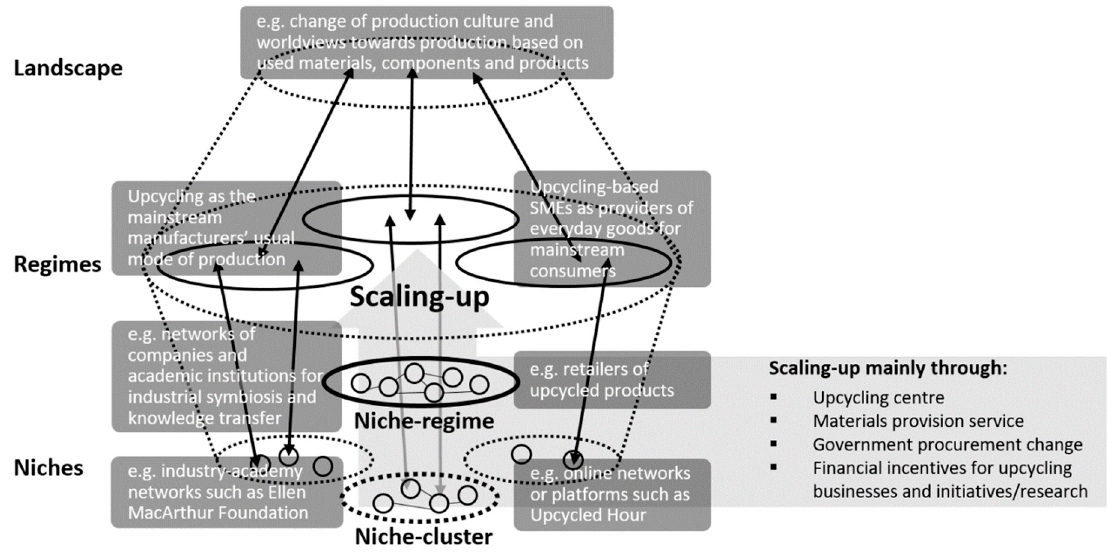
Figure 8. Scaling up of upcycling in production domain [15].